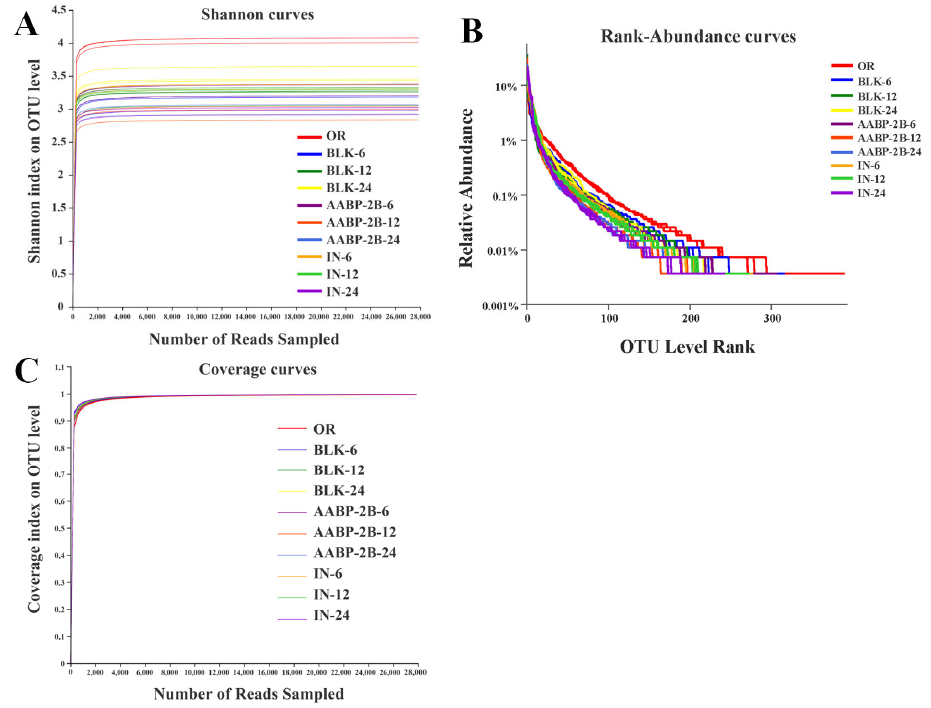
in accordance with the PCA results, illustrating that AABP-2B and IN have similar impacts